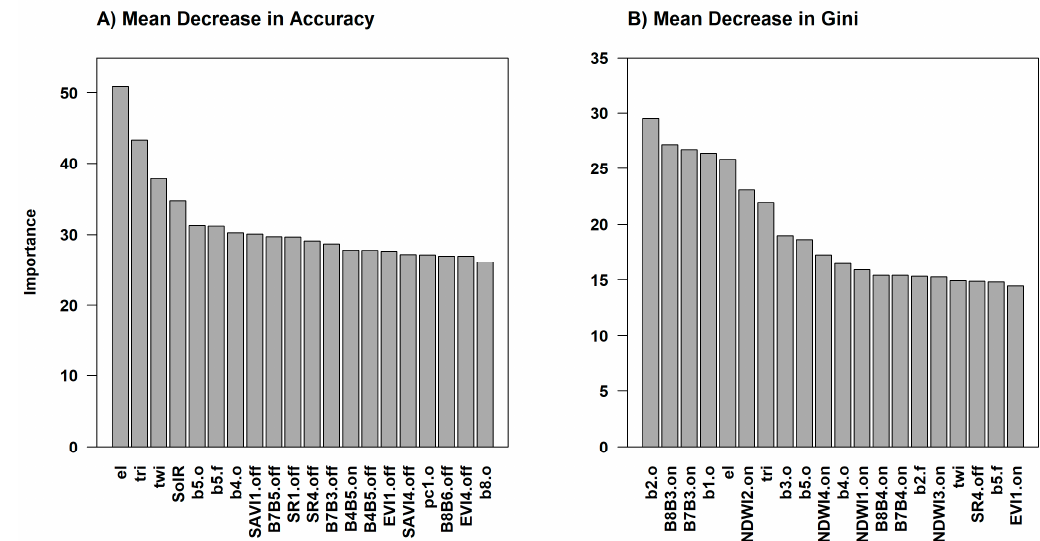
Figure 13. Overall Random Forest variable importance for Worldview-3 satellite imagery and land cover classification showing the first 20 predictors. For land cover classification, variable importance was measured as the mean decrease in class accuracy and the Gini index of node impurity with each predictor variable held out of the model over n = 2000 classification trees.